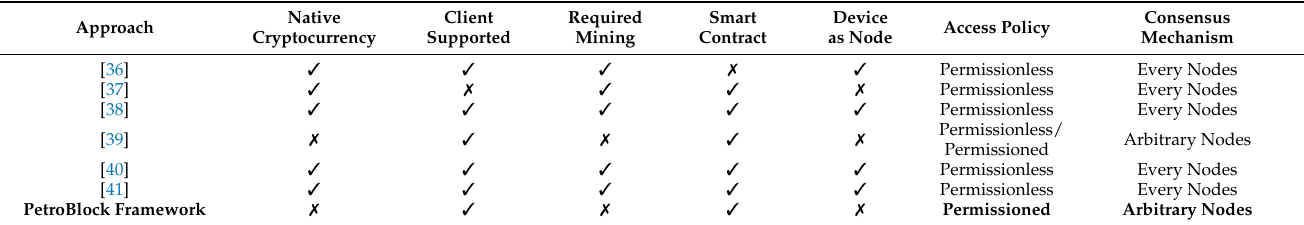
Table 6. Comparative analysis of proposed PetroBlock framework with existing platforms. Approach Native